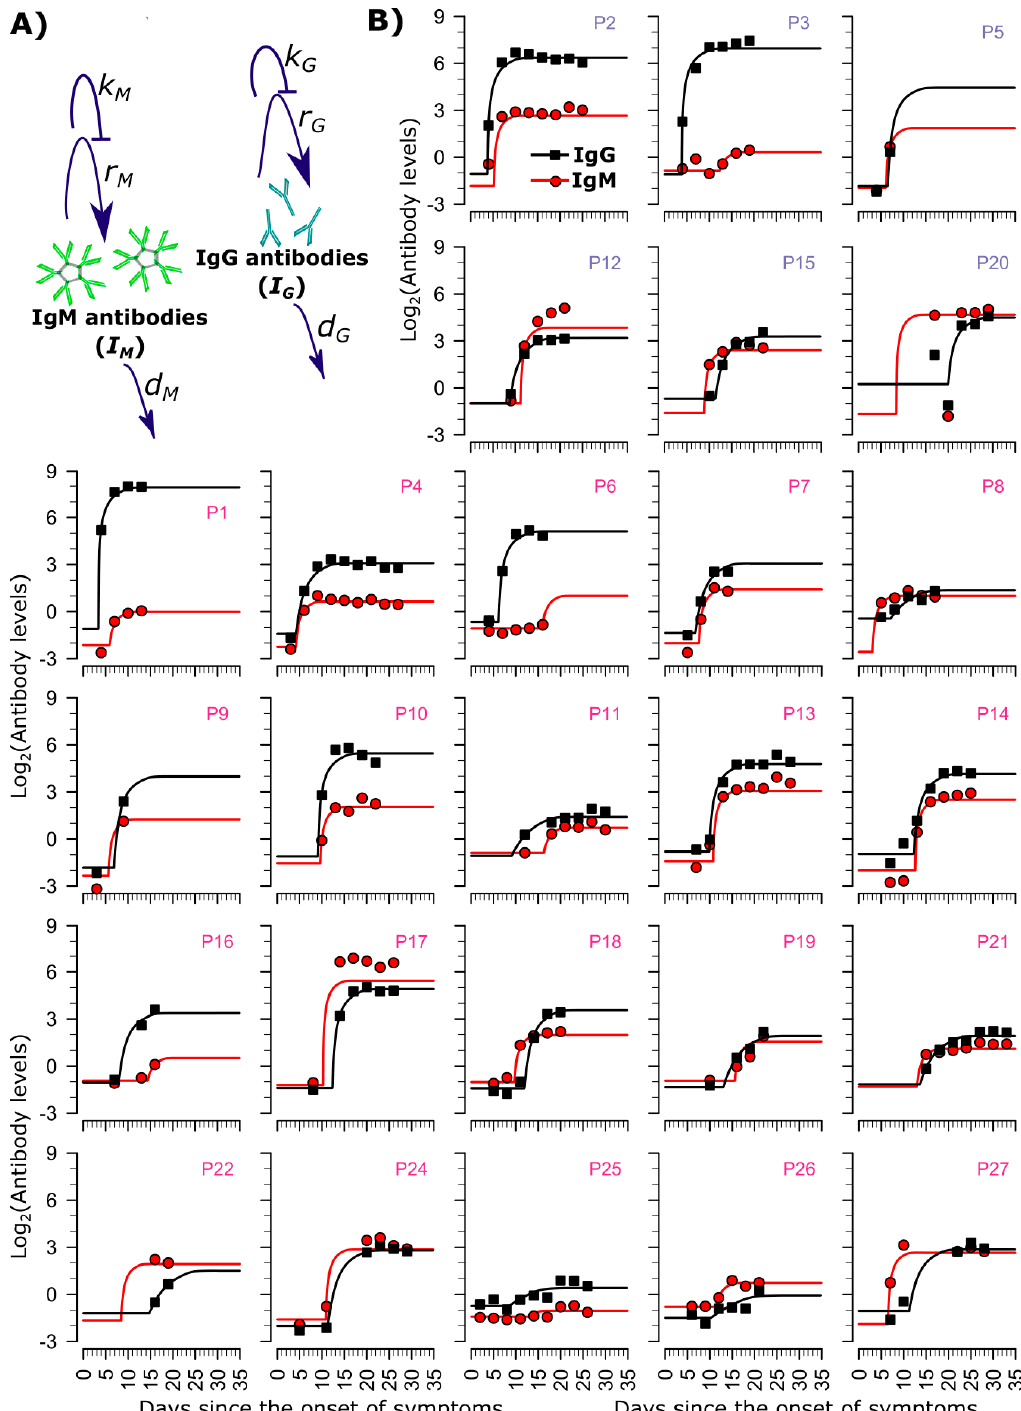
Figure 1. The mathematical model fits SARS-CoV-2 IgG and IgM levels following infection. ( A ) Schematic representation of the mathematical model reproducing longitudinal IgM and IgG dynamics, where r M and r G stand for the antibody production rates, k M and k G regulate the saturation of antibody generation, d M and d G are the natural clearance rates of IgM and IgG, respectively. The parameters used here correspond to the parameters in Equation (3) from the Materials and Methods section (or, model M3 in Table S1), ( B ) Simulations (line), and data (markers) of IgM (red) and IgG (black) under the best model (model M3 in Table S1). Severe and non-severe patients are labeled in blue and pink, respectively.